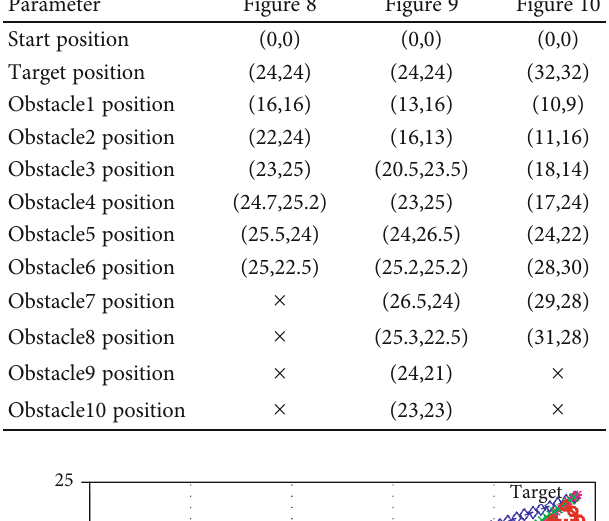
Figure 12: Scenario 2: the result of path planning of the four algorithms with an obstacle.